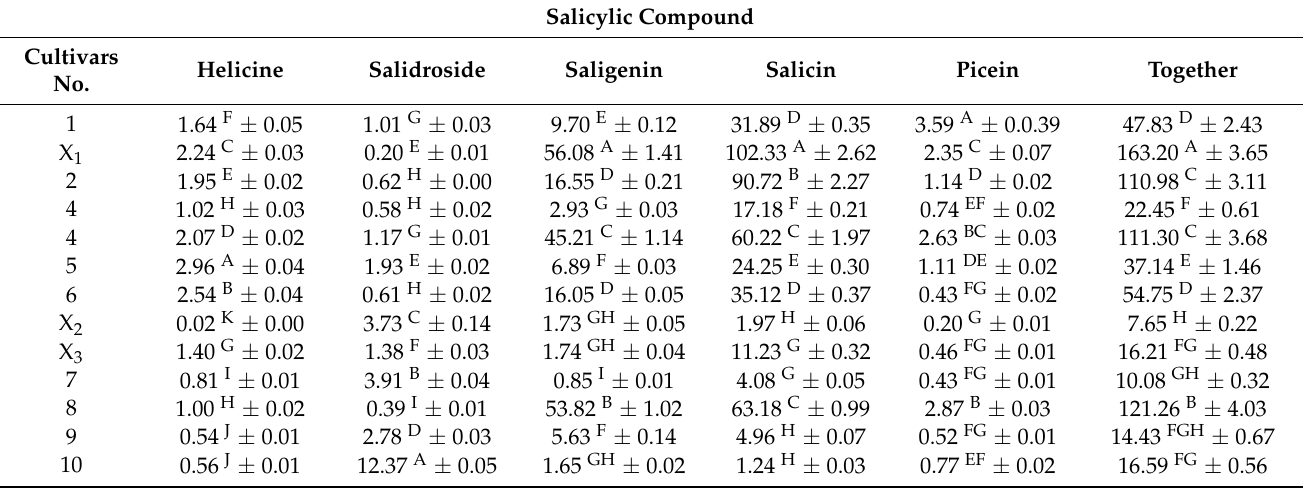
Table 3. The concentration of salicylic compounds in young shoots of the selected willow cultivars, the third 10-day period of May 2017 ( µ g/g DM). The numbers of cultivars as in Table 1. Salicylic Compound Cultivars Helicine Salidroside Saligenin Salicin Picein Together No.